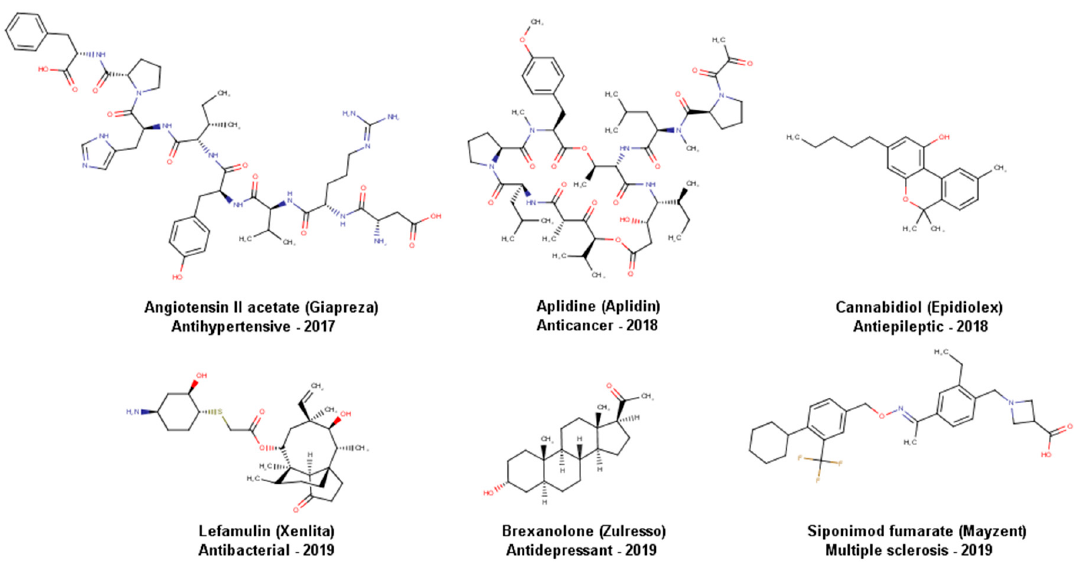
Figure 1. Recent natural products and derivatives approved for clinical use.